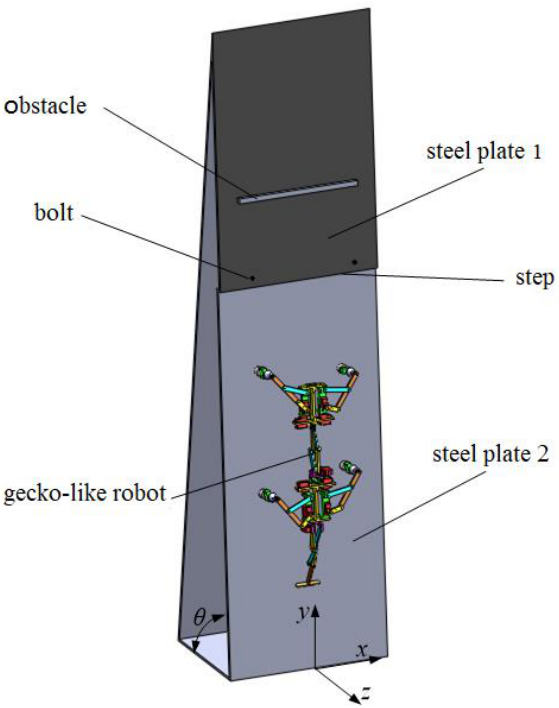
Figure 16. Experimental environment.